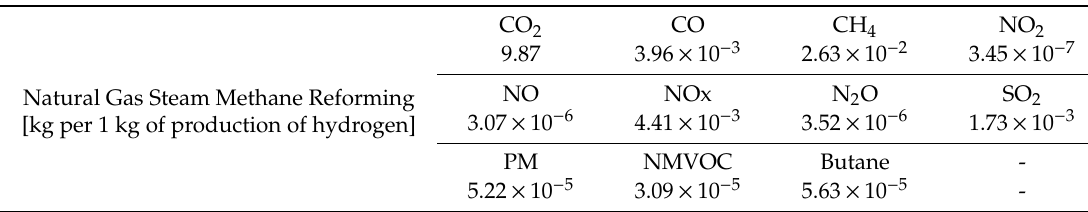
Table A4. Emission factors of steam methane reforming (SMR) process to produce hydrogen in the Well-to-Tank phase.